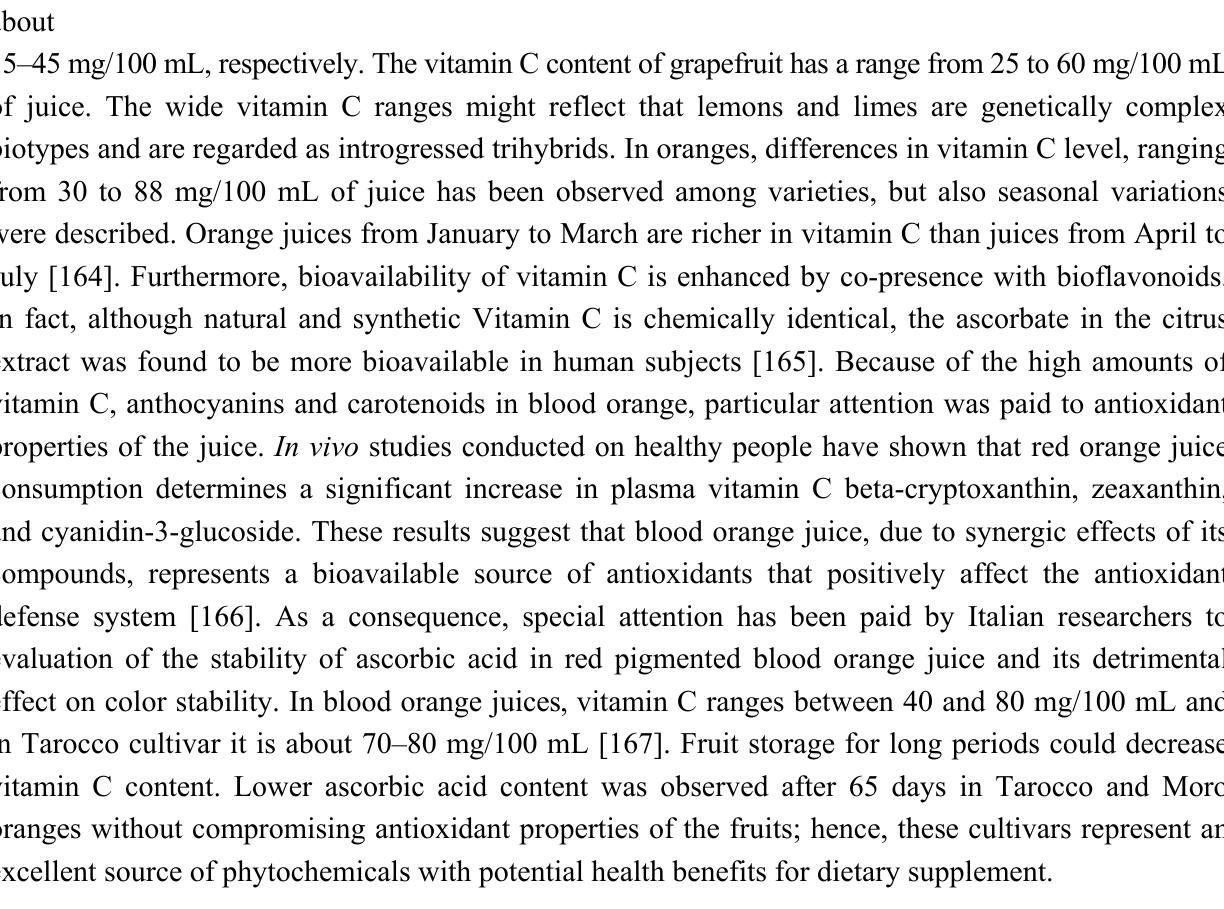
Figure 7. Chemical structures of the flavanones in